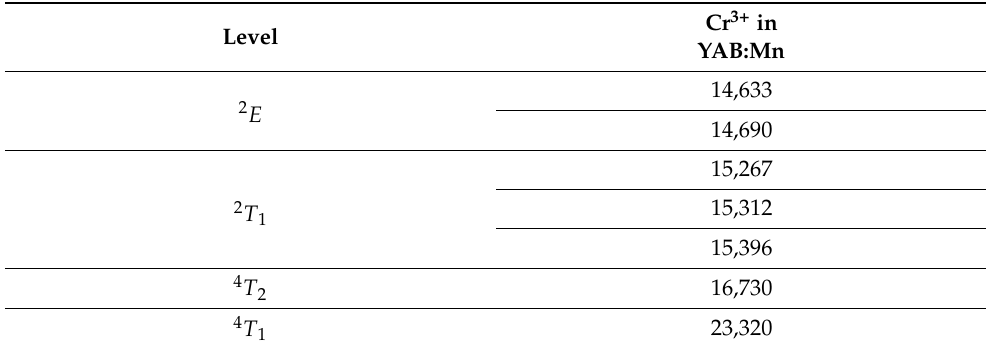
Table 3. Energy values (cm − 1 ) of the 2 E , 2 T 1 (at 5 K), 4 T 2 , and 4 T 1 (at 77 K) levels of uncontrolled Cr 3+ in YAB:Mn determined from the absorption and excitation